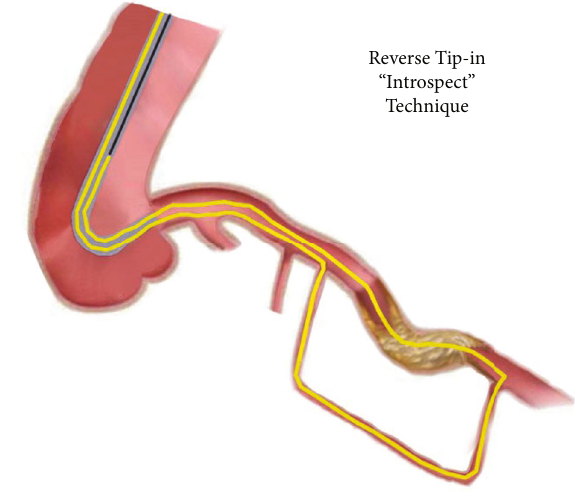
Figure 2: The image depicts the “ reverse tip-in ” technique. Primarily, the fi rst retrograde wire crosses the lesion and with “ introspect technique ” the position of the microcatheter inside the guiding catheter as depicted in this fi gure; the antegrade wire from guiding catheter is tipped into the microcatheter and then with simultaneous pulling backward the microcatheter and retrograde wire and withdrawing the antegrade wire forward; the lesion could be passed via antegrade wire, and with fi nal position of the antegrade wire distal to the lesion, predilation of CTO segment could be